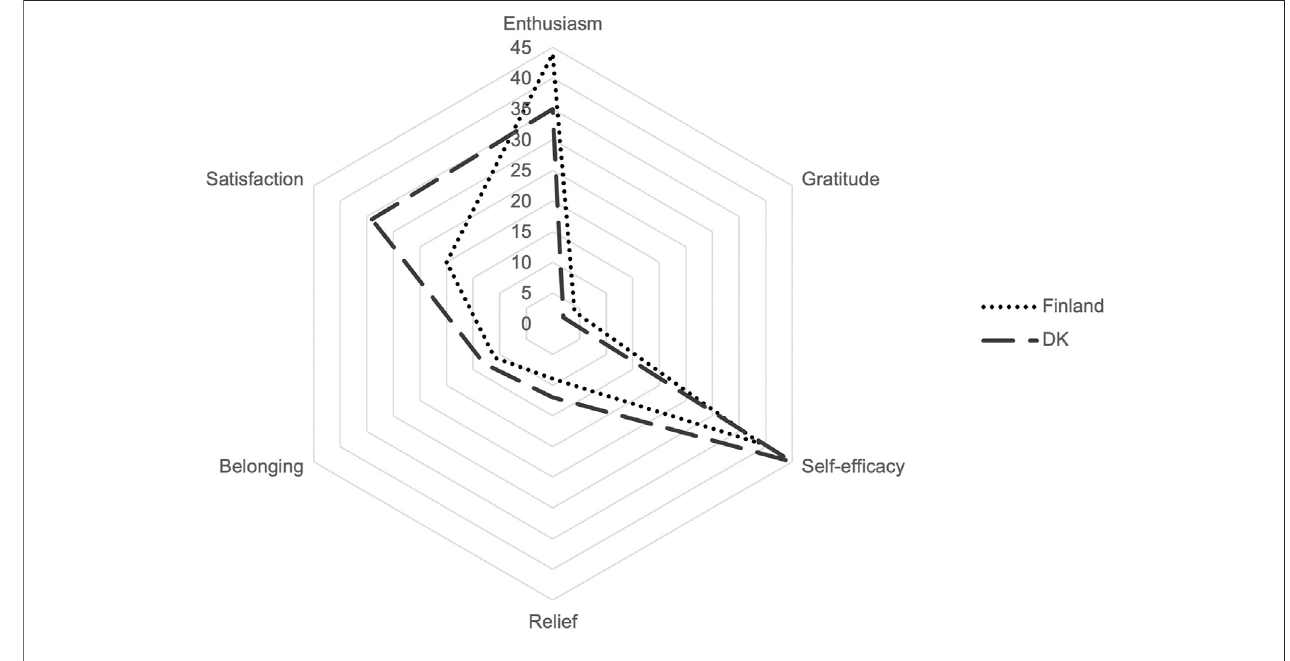
FIGURE 1 | Cross-country comparison of positive emotions.